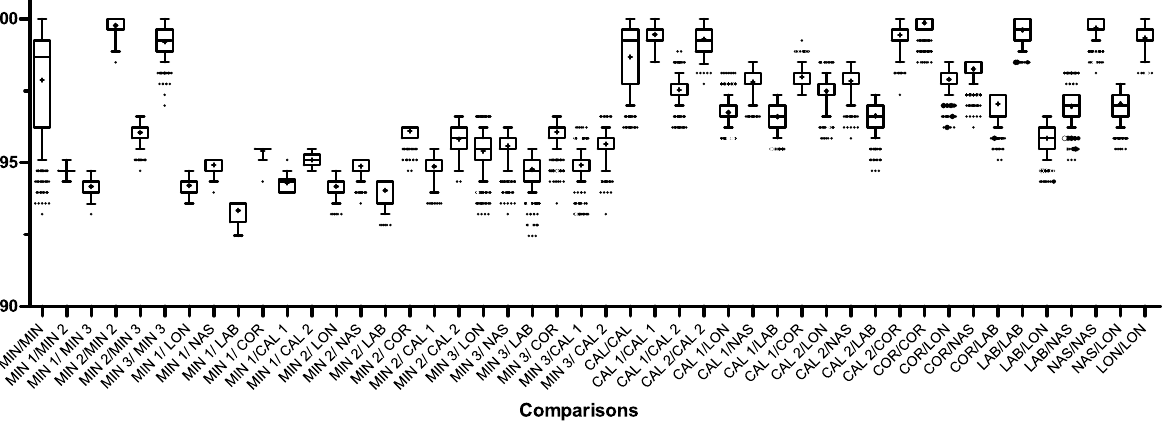
Figure 4. Comparison of sequence identity between different species and operational taxonomical units (OTU) on the internal transcribed spacer 2 sequences. Identities were calculated using dist.dna function from the ape package in R and plotted as boxplots (medians and 25%/75% percentiles) with whiskers showing the 95% percentiles and outliers shown by dots. Means are indicated by crosses. Abbreviations on the x-axis indicate the species Coronocyclus coronatus (COR), Cylicocyclus nassatus (NAS ), Cylicostephanus longibursatus (LON), Coronocyclus labiatus (LAB), Cylicostephanus calicatus (CAL) and Cylicostephanus minutus (MIN). The OTUs of Cys. calicatus (OTU I and II) and Cys. minutus (OTU I, II, III) are represented as CAL 1, CAL 2 and MIN 1, MIN 2 and MIN 3, respectively.